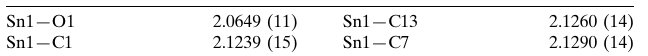
Selected bond lengths (A˚ ).